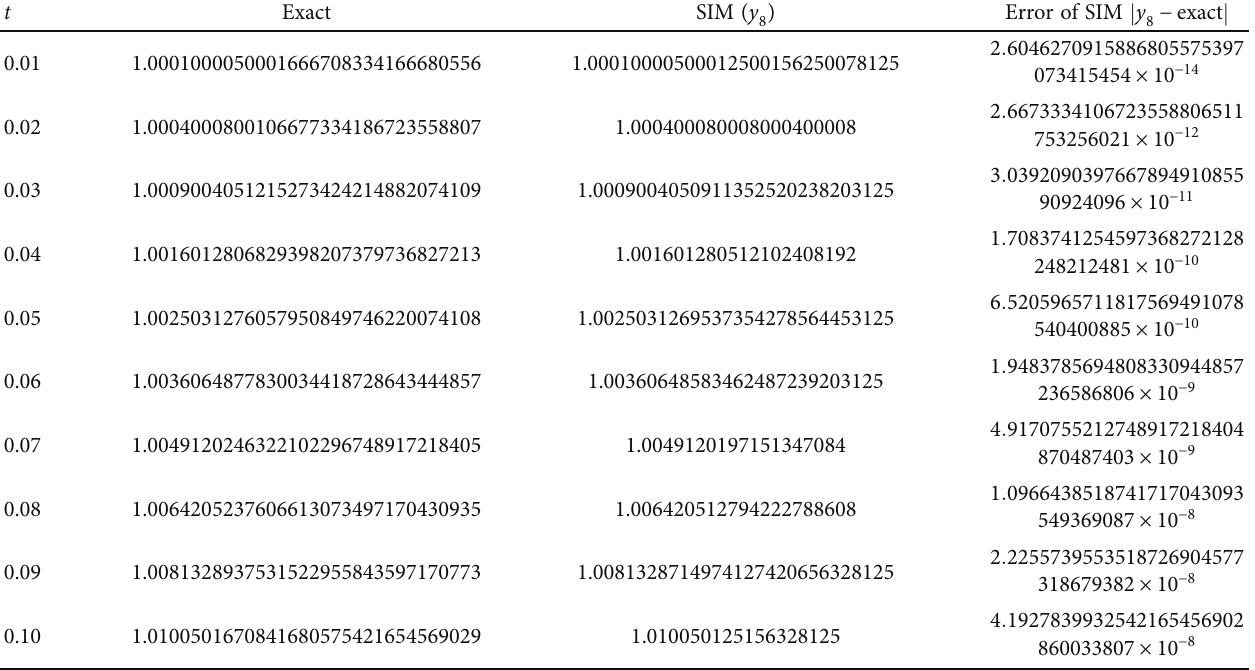
Table 6: Eight-term approximate solution by SIM and comparison with the exact solution of Example 4 for di ff erent values of time variable t and the absolute error E = j y 8 − exact j